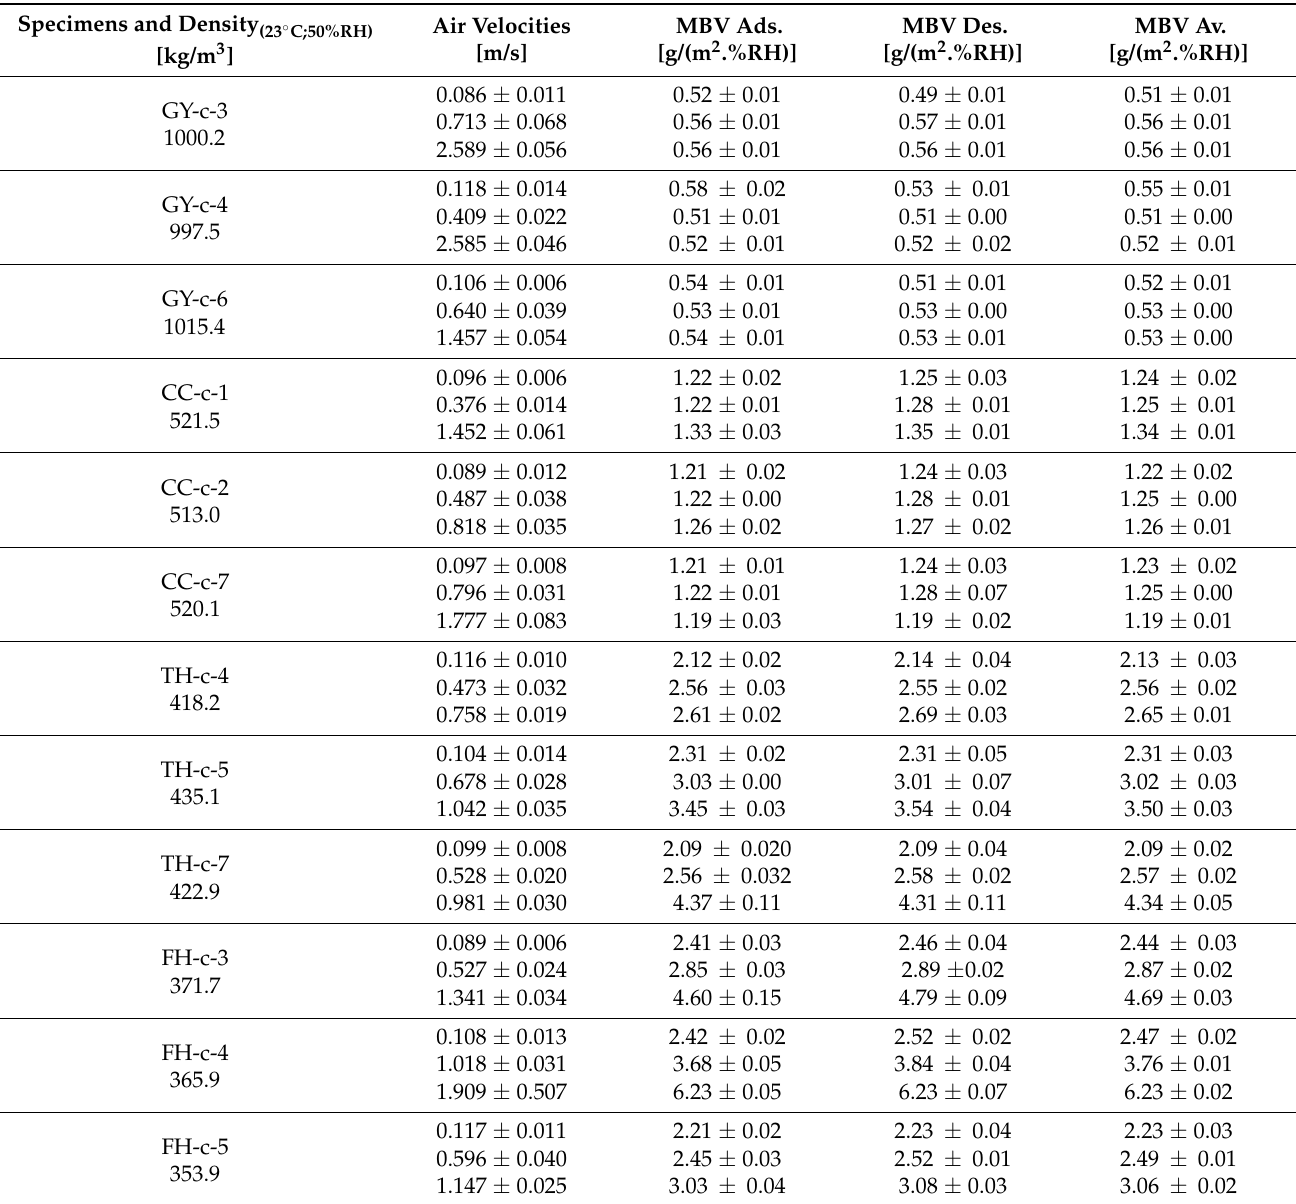
Table 8. Density and MBV (for adsorption and desorption phases and in average) at different air velocities for each